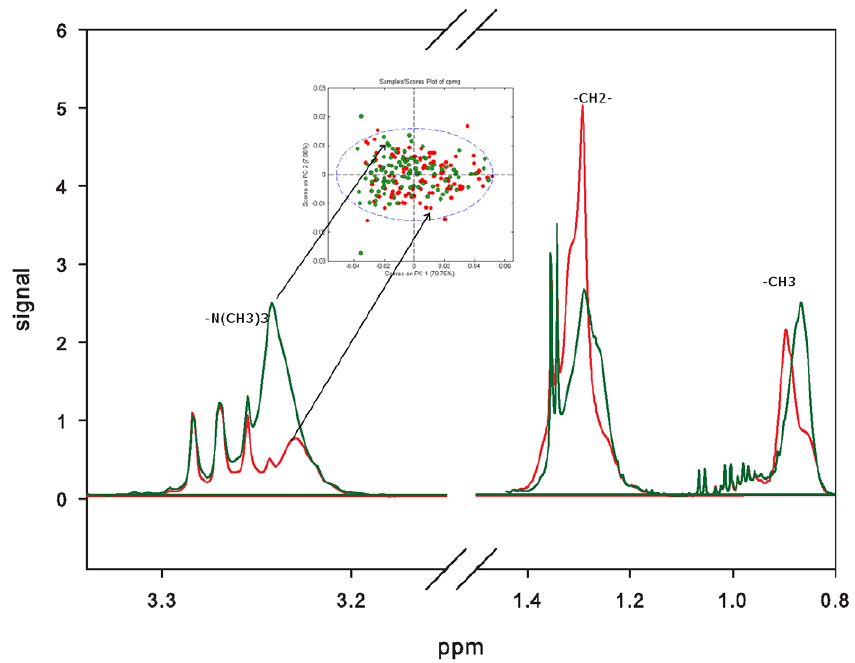
Figure 2. Visualization of the metabolic differences in MR spectra. The green spectrum is from a high VO 2max subject (green dots in PCA score plot) and the red spectrum is from the low VO 2max (red dots in PCA score plot). VO 2max : Maximal oxygen uptake.